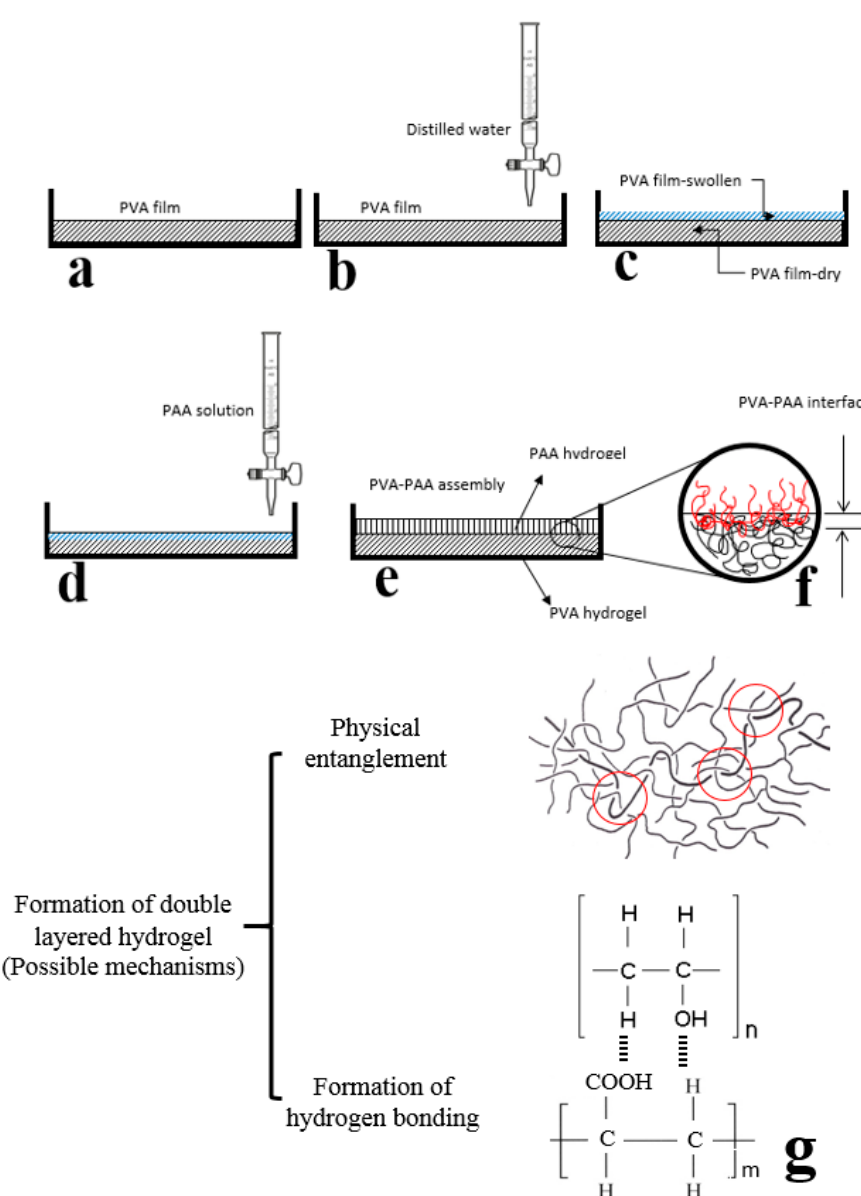
Figure 1. Schematic drawing of sample preparation steps. PAA: poly acrylic acid; PVA: poly